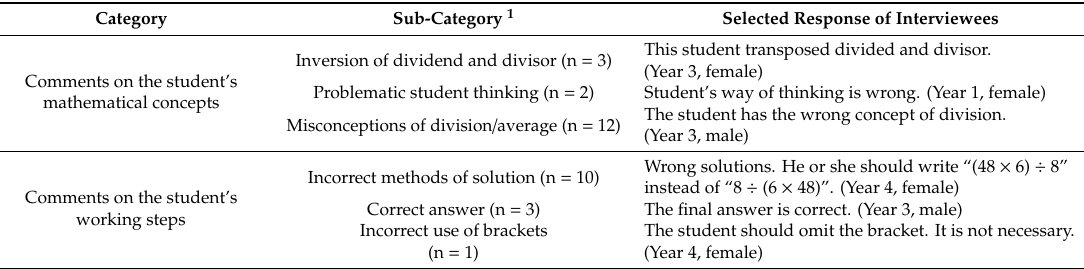
Table 5. Examples for interviewees’ comments on a sixth grader’s